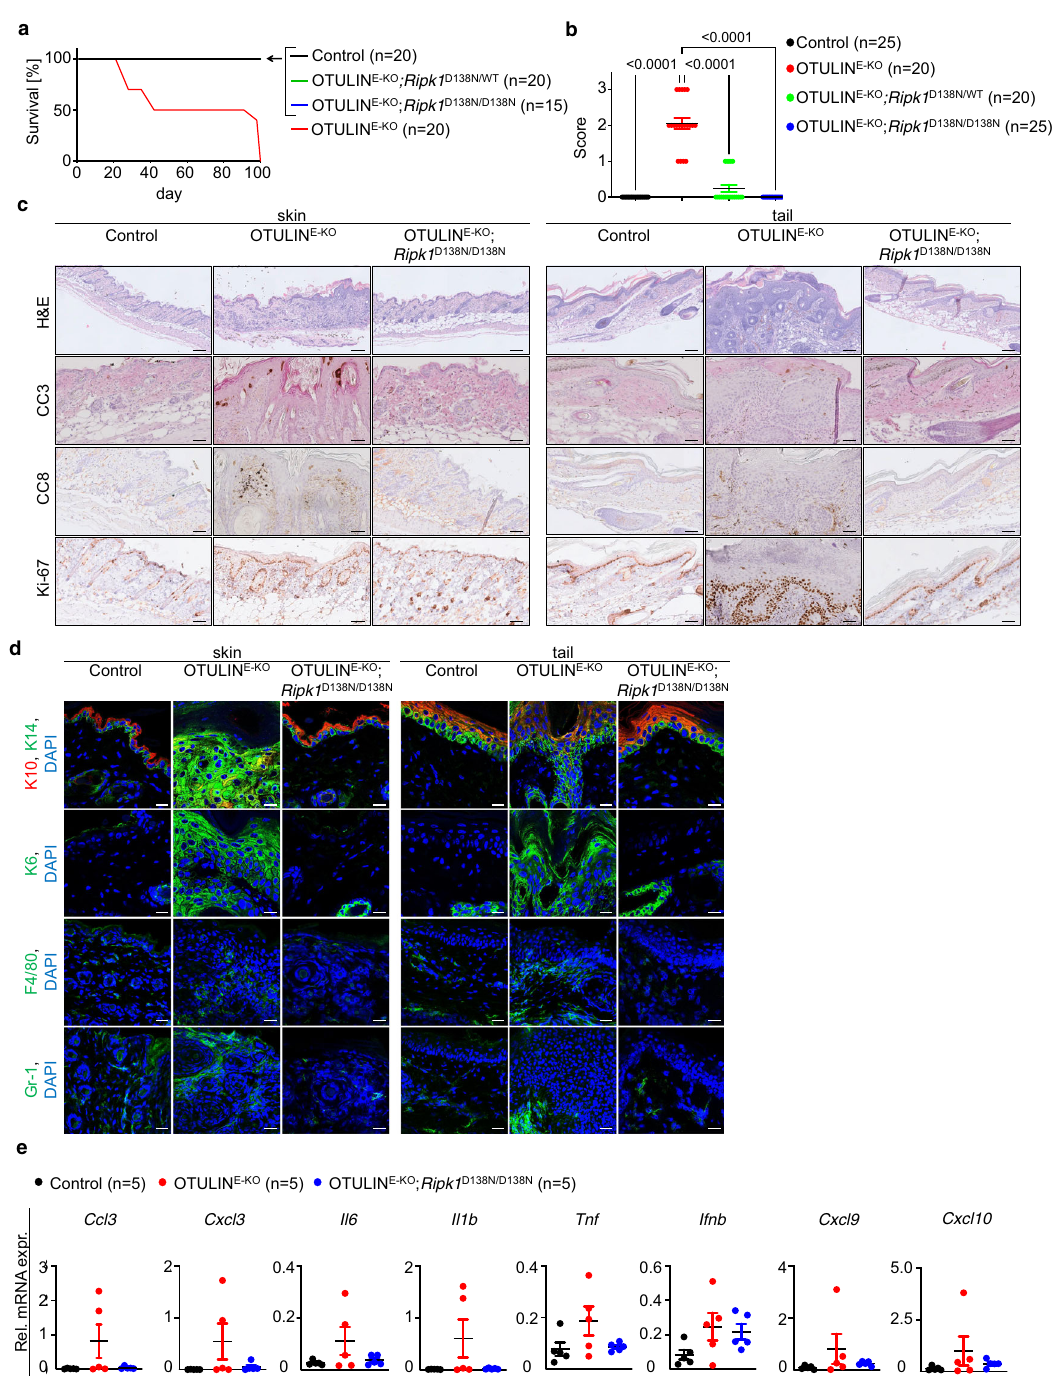
Fig. 4 RIPK1 kinase activity is required for the development of skin in fl ammation in OTULIN E-KO mice. a Kaplan – Meier plot depicting survival of mice of the indicated genotypes. b Graph depicting macroscopic skin score of mice of the indicated genotypes. The dots in the graphs represent individual mice. Mean± s.e.m. is shown for each group of mice in all graphs. Statistical signi fi cance was determined using Kruskal – Wallis test (one-sided). c Representative images of skin sections from 3-week-old mice of the indicated genotypes stained with H&E ( n = 5) or immunostained with anti-CC3 ( n = 3), anti-CC8 ( n = 3) or anti-Ki-67 ( n = 3) antibodies. Scale bars: H&E = 100 μ m; CC3, CC8, Ki-67 = 50 μ m. d Representative images of skin sections from 3-week-old mice of the indicated genotypes, immunostained with anti-K10, anti-K14 ( n = 4), anti-K6 ( n = 3), anti-F4/80 ( n = 3) and anti-Gr-1 ( n = 3) antibodies and counterstained with DAPI (DNA stain). Scale bars: K10, K14, K6 = 20 μ m; F4/80, Gr-1 = 30 μ m. e Graphs depicting relative mRNA expression of the indicated genes in RNA from whole-skin tissue of 3-week-old mice of the indicated genotypes, measured by qRT-PCR. The dots in the graphs represent individual mice. Mean ± s.e.m. is shown for each group of mice in all graphs. Statistical signi fi cance was determined using Kruskal – Wallis test (one-sided). Control mice include littermates that do not express K14-Cre . Source data for a , b , e are provided as a Source data fi